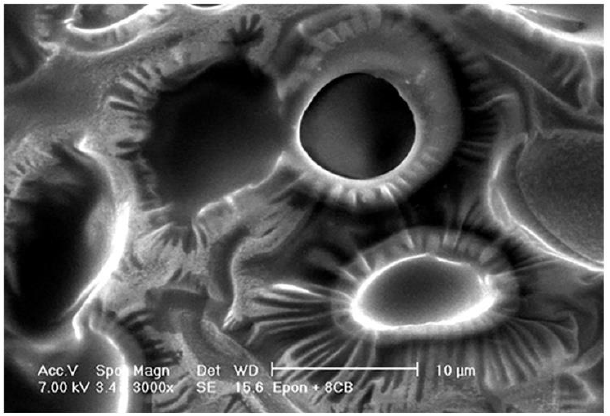
Figure 26. SEM micrograph of geometrically irregular LC dispersions embedded in a polymeric matrix.